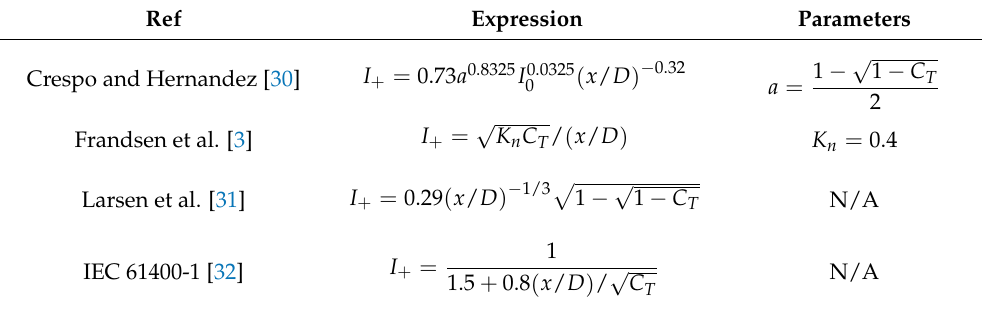
Table 3. Wake models for added turbulence intensity.